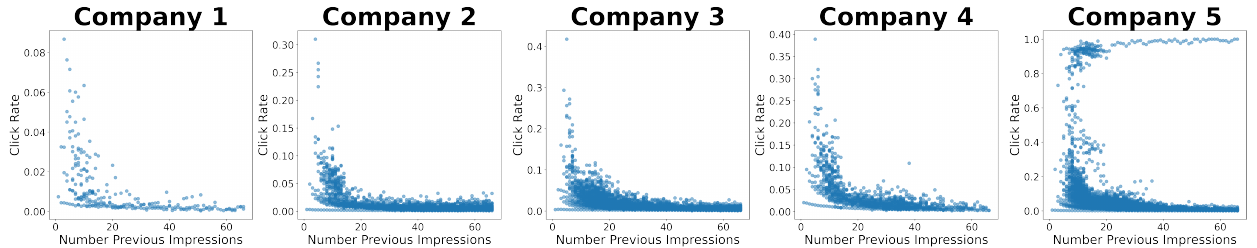
Figure 4. Click rate in each state for each client based on the number of impressions that the user have received.